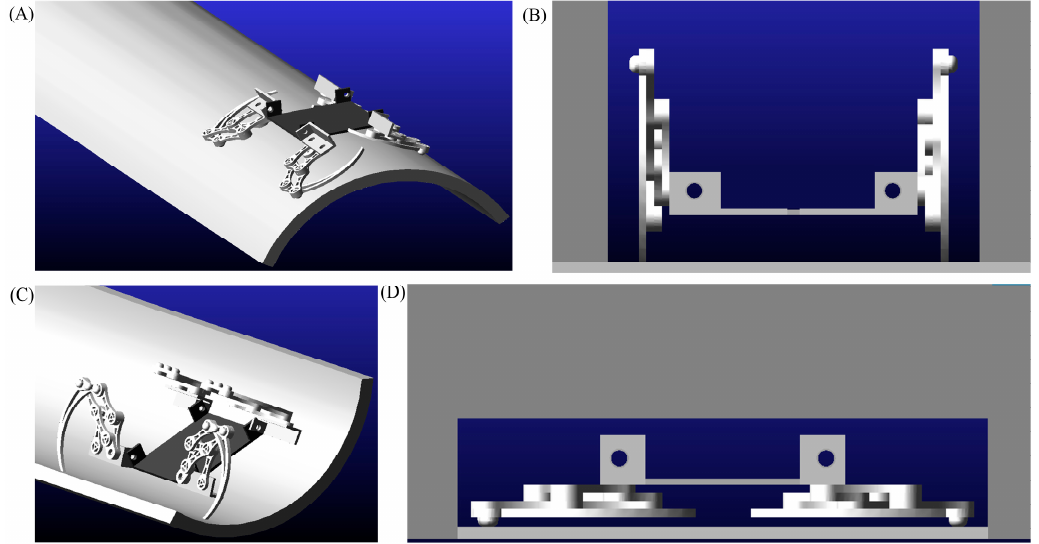
Figure 7. The robot moves in several unstructured environments as shown in Figure 1. ( A ) The outer surface of the arc; ( B ) width-constrained environment; ( C ) the inner surface of the arc; ( D ) height- constrained environment.